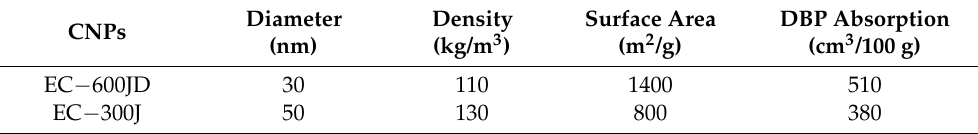
Table 1. Material parameters of CNPs.